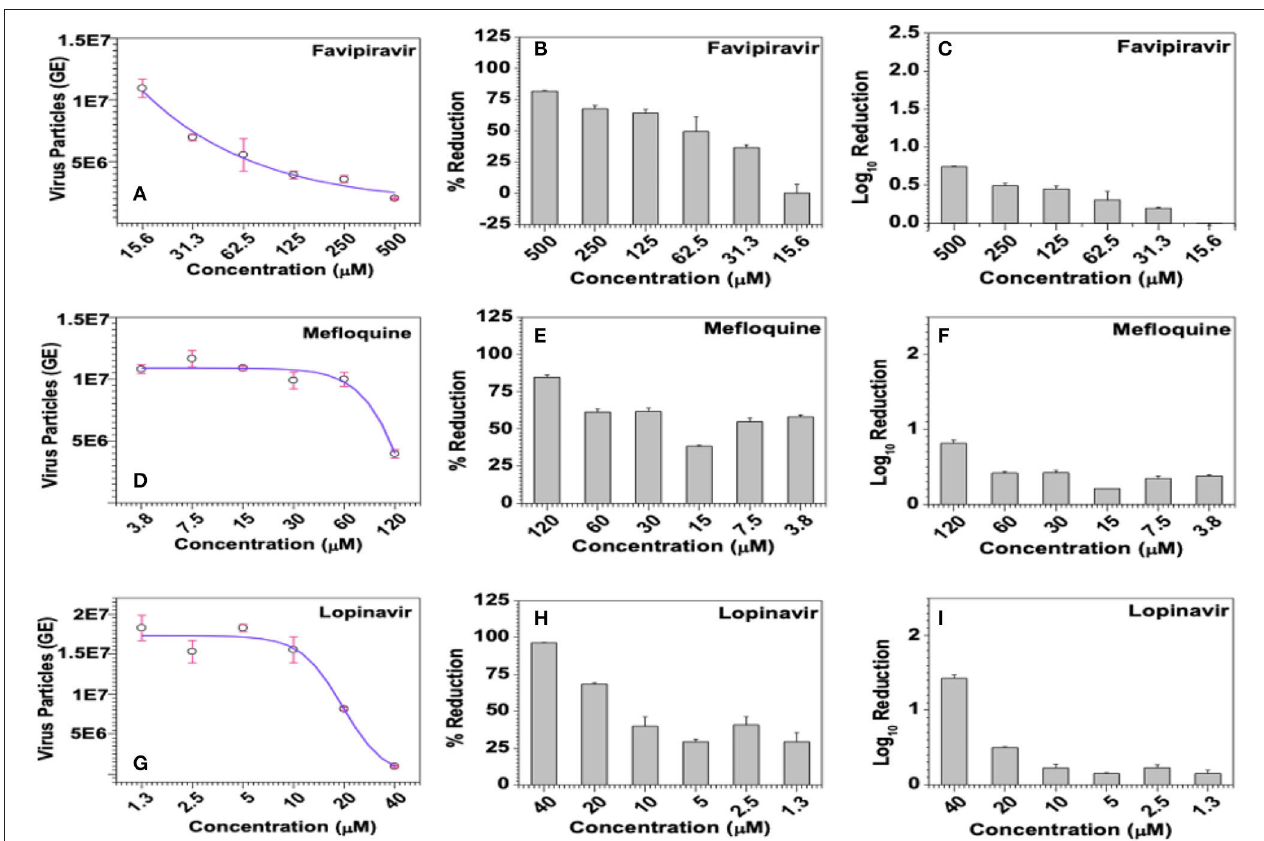
FIGURE 9 | Effect of the selected compounds on virus titers. (A–C) Favipiravir, (D–F) Mefloquine, and (G–I) Lopinavir were incubated with HCoV-229E-infected ( @ 1.0 MOI) MRC-5 cells at the indicated concentrations for 6 days, virus-infected culture supernatants from triplicate wells were individually processed to extract viral genomic RNAs and quantified by SYBR Green-based qPCR using primer pair targeting a 70-base region in the cDNA coding for the viral membrane protein. Ten-fold serial dilutions of the recombinant plasmid carrying the target 70-base region were used to generate the standard curve, titers of virus particles (A,D,G) , represented as genome equivalents (GE), were derived from the standard curve as detailed in methods and the data was used to calculate % inhibition (B,E,H) , and log 10 inhibition (C,F,I) in viral